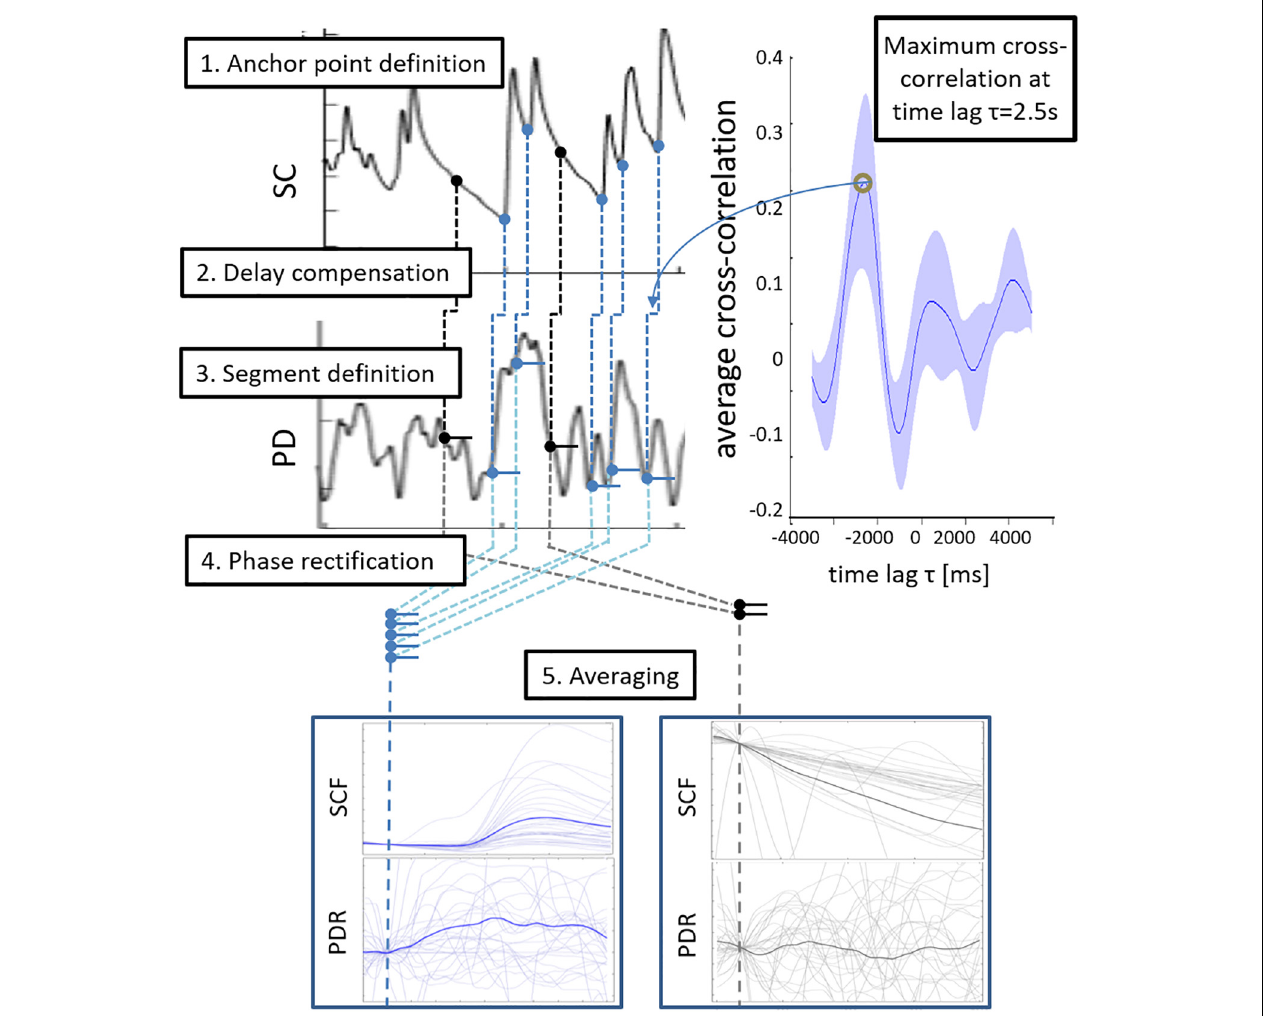
FIGURE 1 | Schematic illustration of the bivariate phase rectified signal averaging (PRSA) procedure. Step 1: Onsets of skin conductance fluctuations (SCF) served as anchor points (blue circles). Randomly defined anchor points were used as reference condition (black circles). Step 2: Anchor points were transferred to the pupil diameter signal (PD) with a temporal delay of 2.5 s as the mean cross correlation function of skin conductance and PD changes reached its maximum at this time lag. Step 3: Delay-compensated anchor points were used to extract segments of pupil diameter responses (PDR). Step 4: Segments were phase-rectified and normalized. Step 5: PDR segments were averaged and